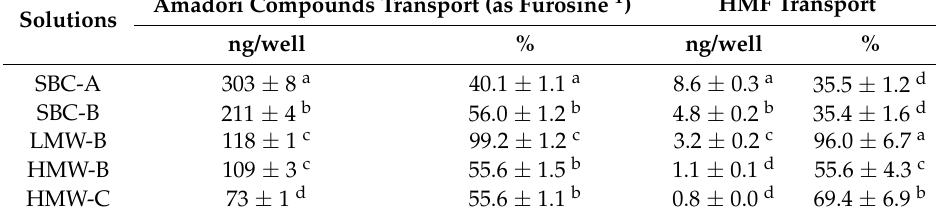
Table 2. Amadori compounds (as furosine 1 ) and HMF transport in Caco-2 cell monolayer after 2 h of incubation with digested bread crust or its fractions.